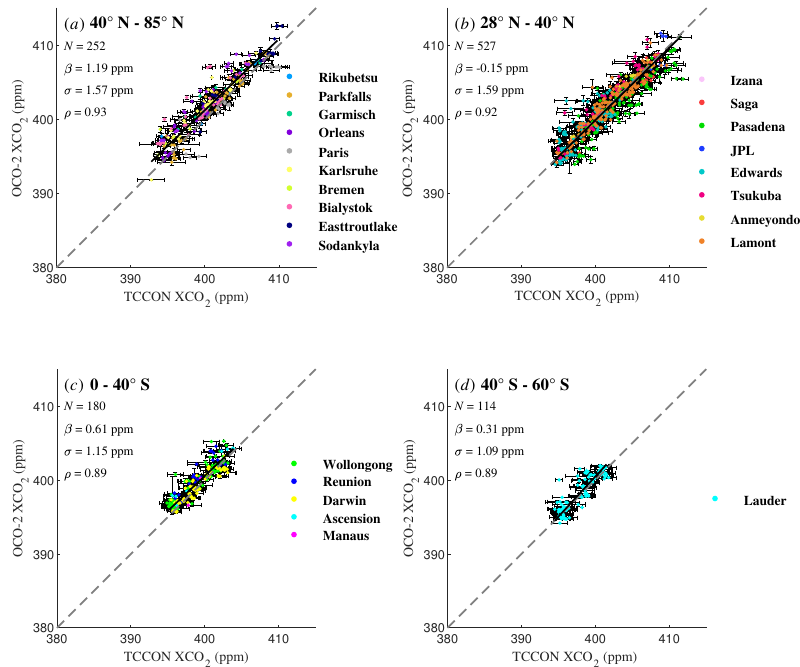
Figure 6. Scatter plots of the collocations of the TCCON and OCO-2 XCO 2 in the four latitude zones that are binned around the TCCON sites: ( a ) 40 ◦ N–85 ◦ N; ( b ) 28 ◦ N–40 ◦ N; ( c ) 0–40 ◦ S; and ( d ) 40 ◦ S–60 ◦ S. The vertical error bars represent the standard deviations of the OCO-2 data, while the horizontal bars represent the standard deviations of the TCCON data. Each TCCON site is represented by a certain